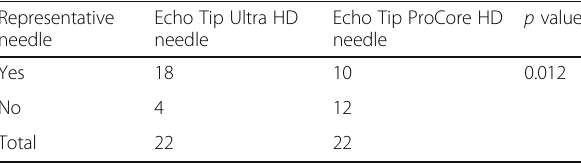
Table 2 Comparison between both needles regarding the representative cellularity of the sample Representative